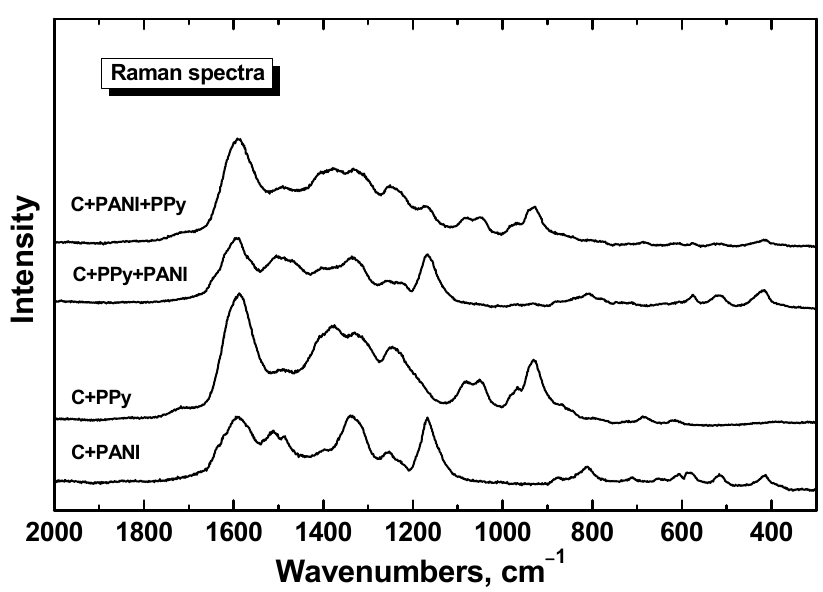
Figure 6. Raman spectra of cotton fabrics coated with polyaniline (C+PANI) or polypyrrole (C+PPy). Polyaniline-coated cotton was again coated with polypyrrole (C+PANI+PPy) or vice versa (C+PPy+PANI). Laser excitation wavelength 633 nm.